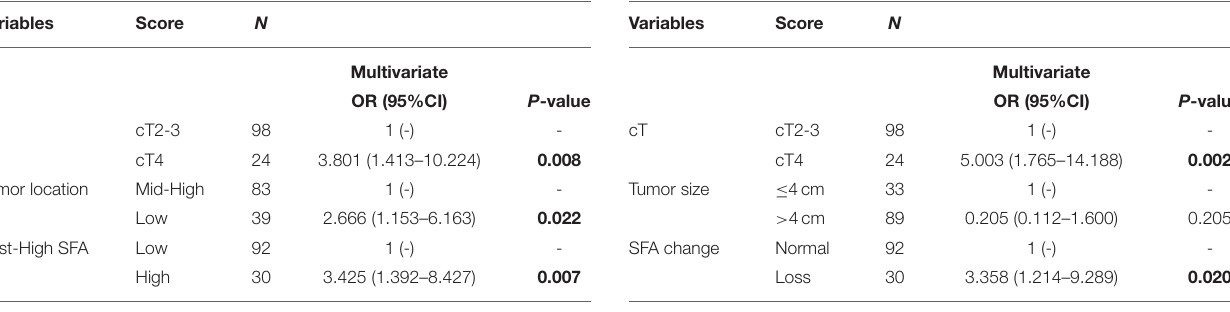
TABLE 4 | Multivariate logistic regression analysis for downstaged LARC